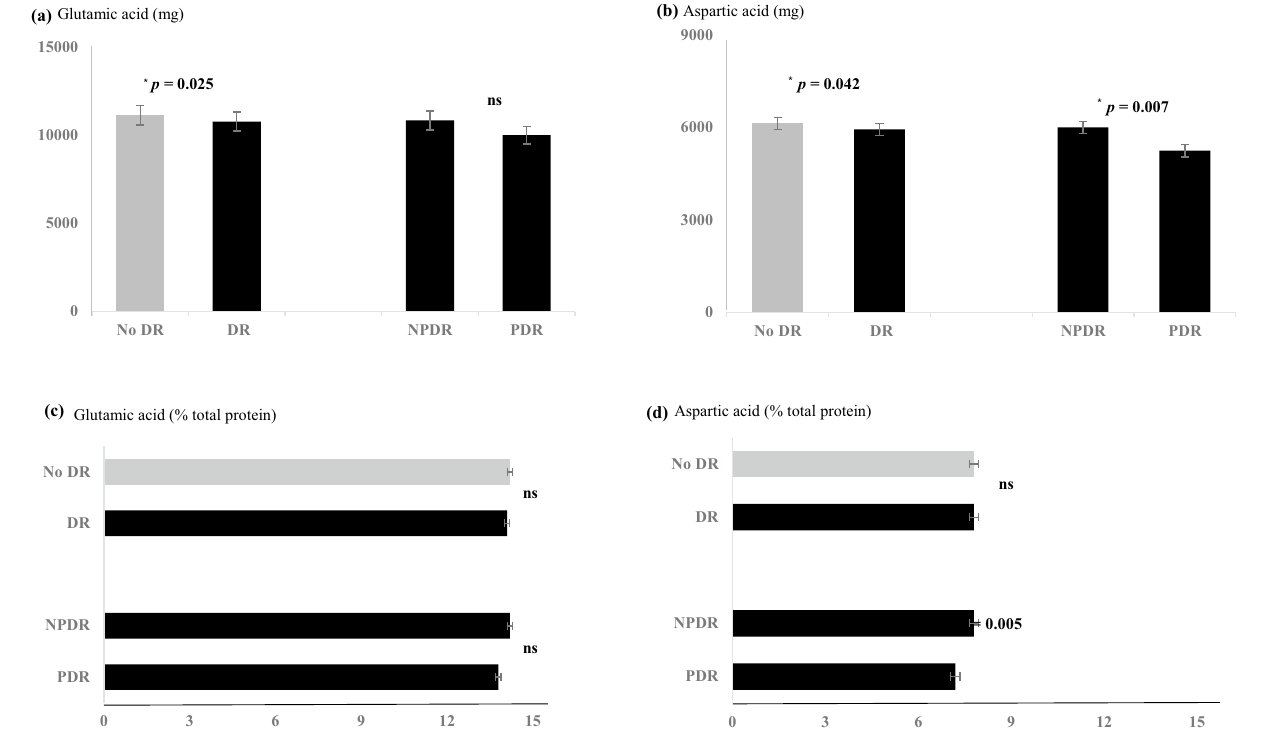
Figure 2. The differences of glutamic acid and aspartic acid intakes (mg or % total protein). The glutamic acid ( a ) and aspartic acid intakes ( b ) were lower in the DR group than those in the non-DR. There was no difference in proportion of total protein of glutamic acid ( c ) and aspartic acid ( d ). The absolute intake ( b ) and proportion of total protein ( d ) of aspartic acid were lower in the PDR group than those in the NPDR group. By